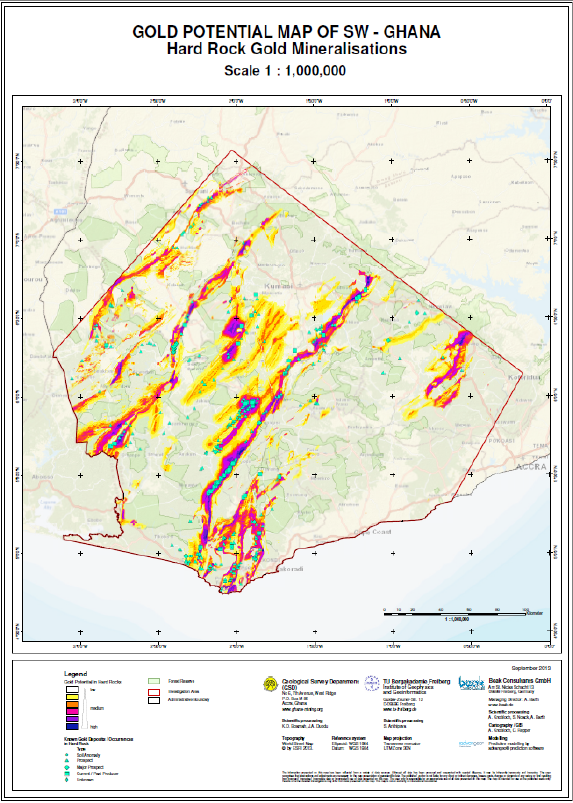
Figure 10. Hard Rock Gold Potential Map